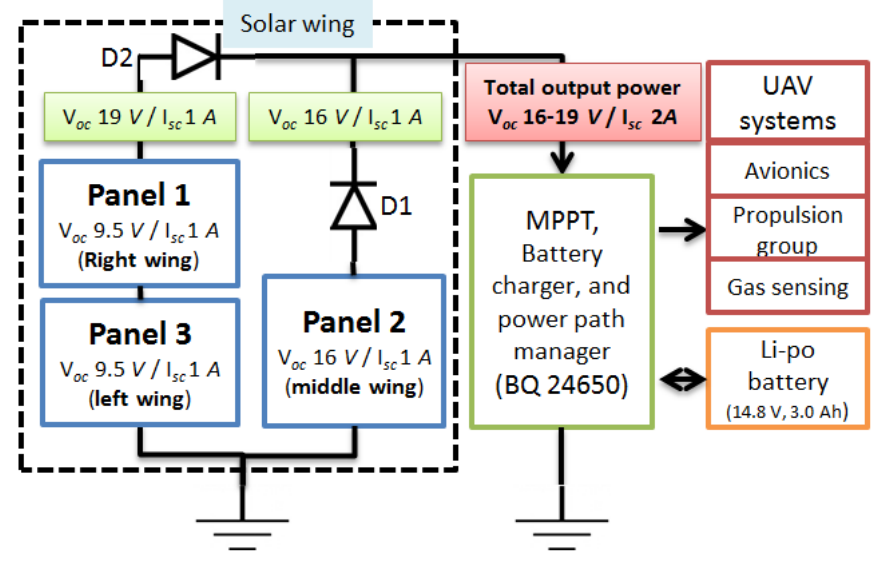
Figure 14. Panel configuration for the solar